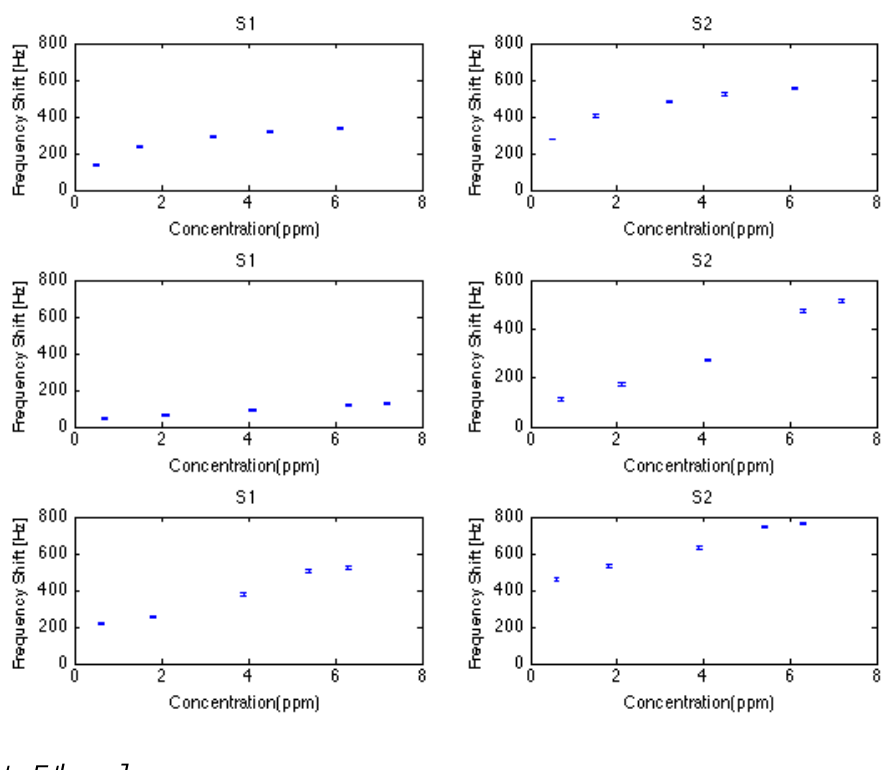
Figure 2. Calibration curves of S1 and S2 (QMB sensors) for three compounds: ethanol, hexane and